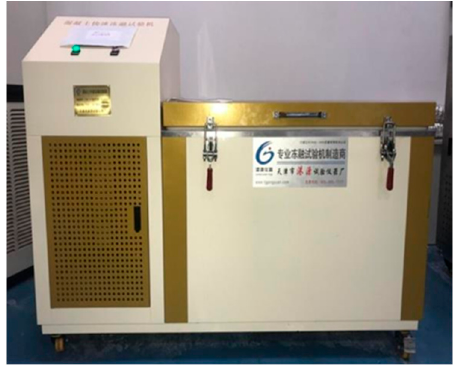
Figure 2. Rapid freeze–thaw test machine for concrete.